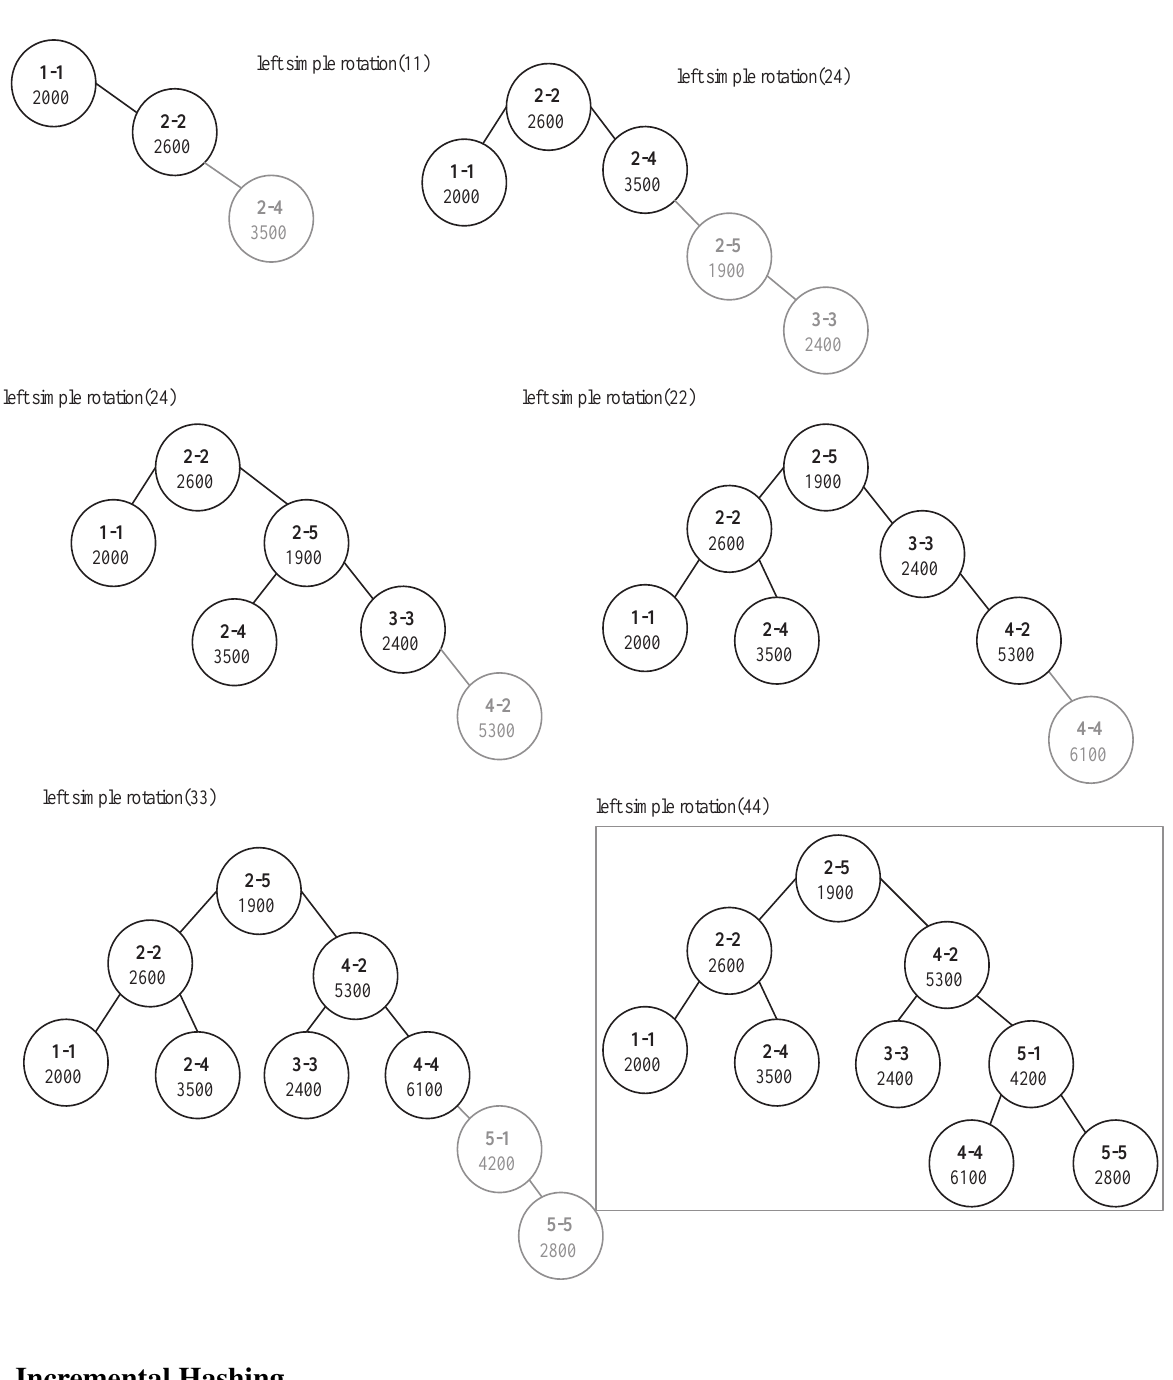
Figure 5. Balanced BST corresponding to the matrix of Figure